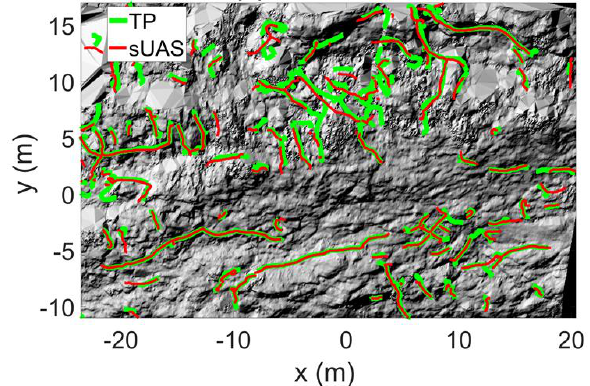
Figure 5. Matched edges in the Idaho Springs dataset for the TP and sUAS